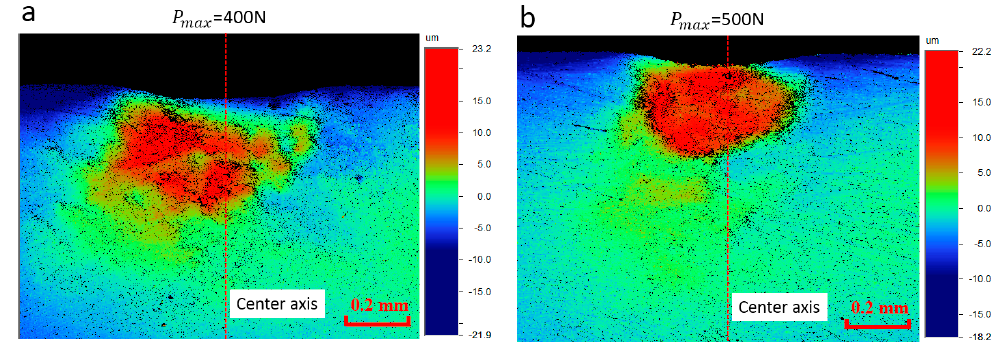
Figure 2. Out-of-plane residual deformation field obtained from indentation experiments using different prescribed loads: ( a ) the prescribed indentation load is 400 N; and ( b ) the prescribed indentation load is 500 N.